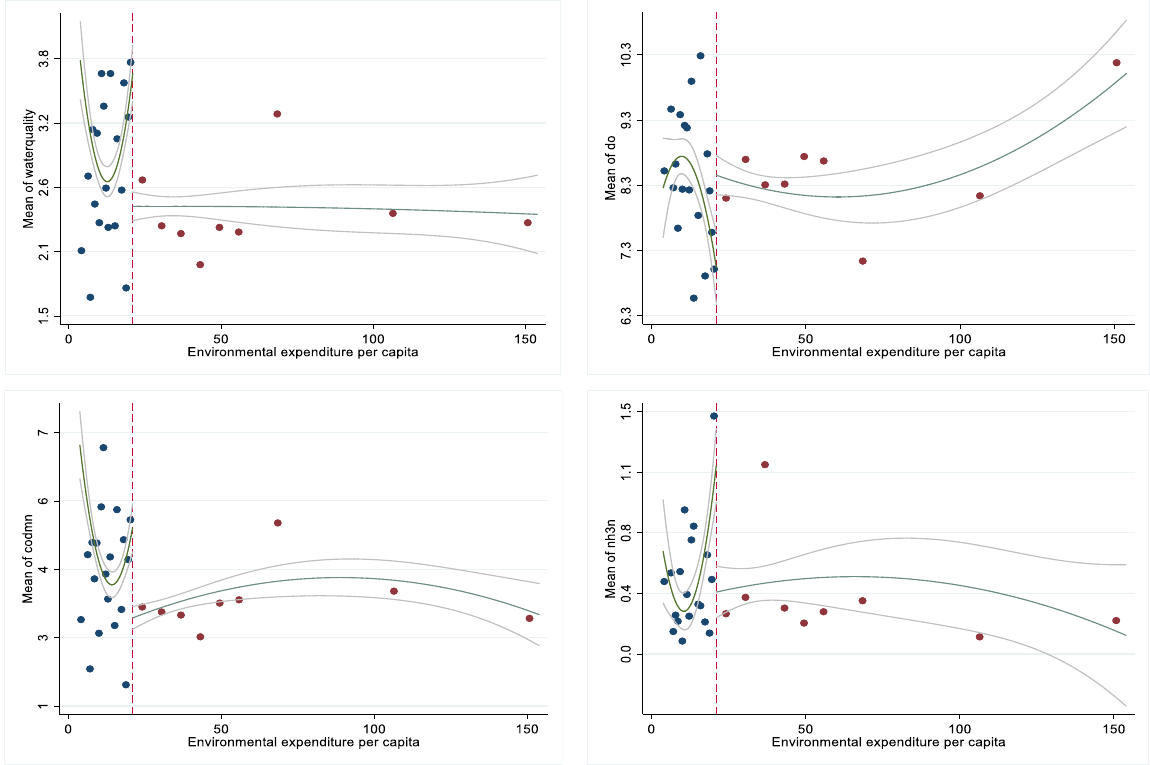
Figure 4. The discontinuities of per capita environmental expenditure after the implementation of RCS. Note: The x-coordinate represents per capita environmental expenditure, and the y-coordinate represents water quality.